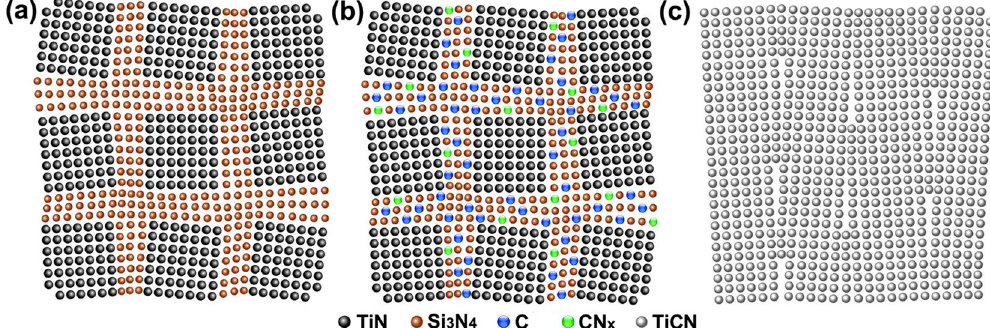
Figure 6. Schematic illustration of microstructural evolution of the TiSiCN nanocomposite film with the different C/Si content ratios. ( a ) 0:4. The Si 3 N 4 interfaces surround the TiN nanocrystallites. ( b ) 2:2. The TiN nanocrystallites are surrounded by the Si 3 N 4 /C/CN x interfaces, which present a crystallized form and coordinate the coherently-epitaxial growth between the TiN nanocrystallites and interfaces. ( c ) 4:0. The nanocomposite structure disappears and the columnar structure